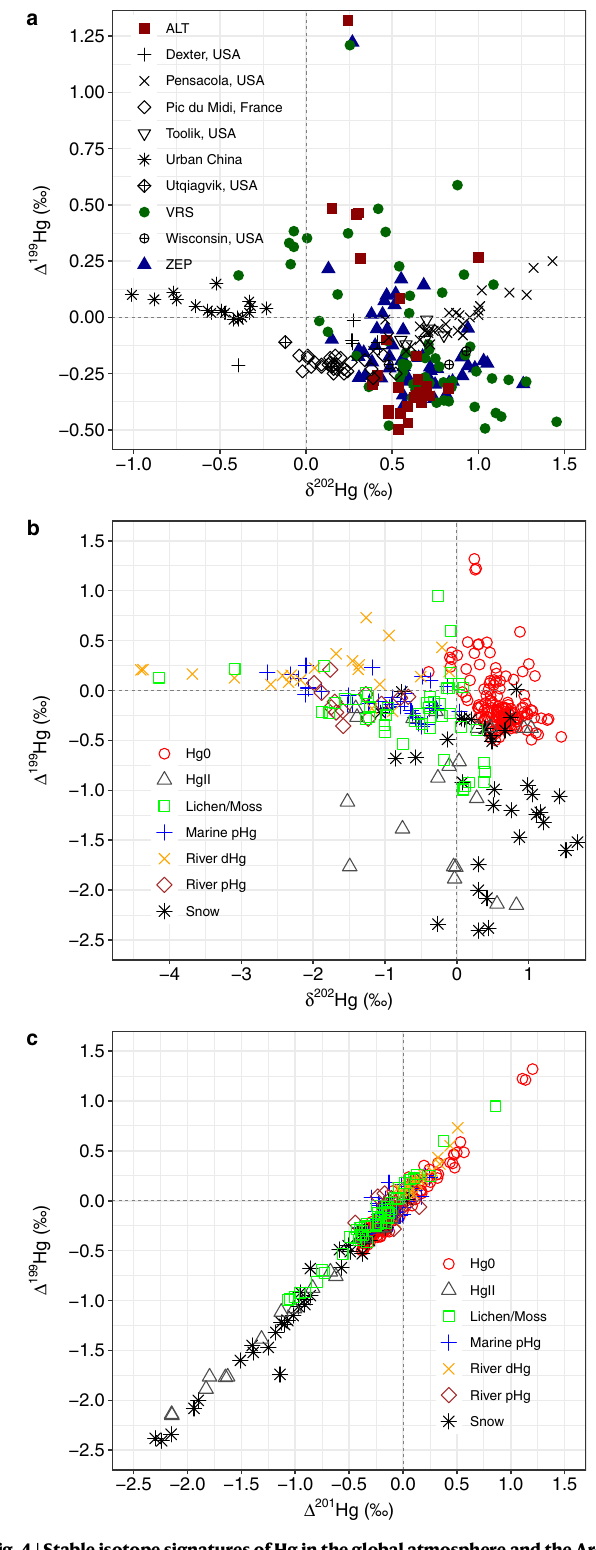
Fig.4|StableisotopesignaturesofHgintheglobalatmosphereandtheArctic environment. Mass-dependent ( δ 202 Hg) and mass-independent ( Δ 199 Hg) Hg 0 iso- tope signatures ( a ) at different global locations and b for different Arctic pools. c Mass-independent( Δ 201 Hg)andmass-independent( Δ 199 Hg)isotopesignaturesfor different Arctic pools. Arctic Hg 0 Δ 199 Hg variability ( − 0.50 to 1.32 ‰ ) is much larger than the NH background Δ 199 Hg at remote sites. Reported literature data is sum- marized in the Supplementary